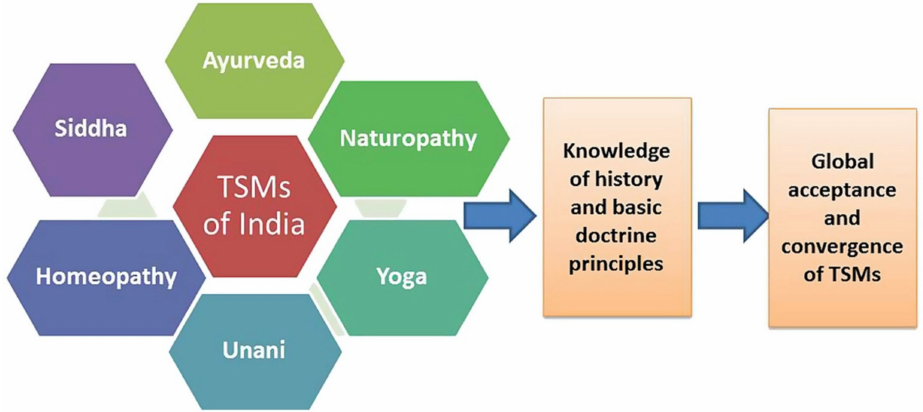
Figure 2. Traditional systems of medicine (TSMs) of India. Reproduced with permission from Elsevier. Figure obtained from an article published in Journal of Traditional and Complementary Medicine, 7 (1), Jaiswal YS, Williams LL, A glimpse of Ayurveda—The forgotten history and principles of Indian traditional medicine, 50–53, Copyright Elsevier